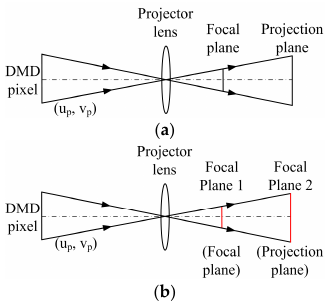
Figure 9. Model of an out-of-focus projector: ( a ) original model; and, ( b ) double the focal plane model.